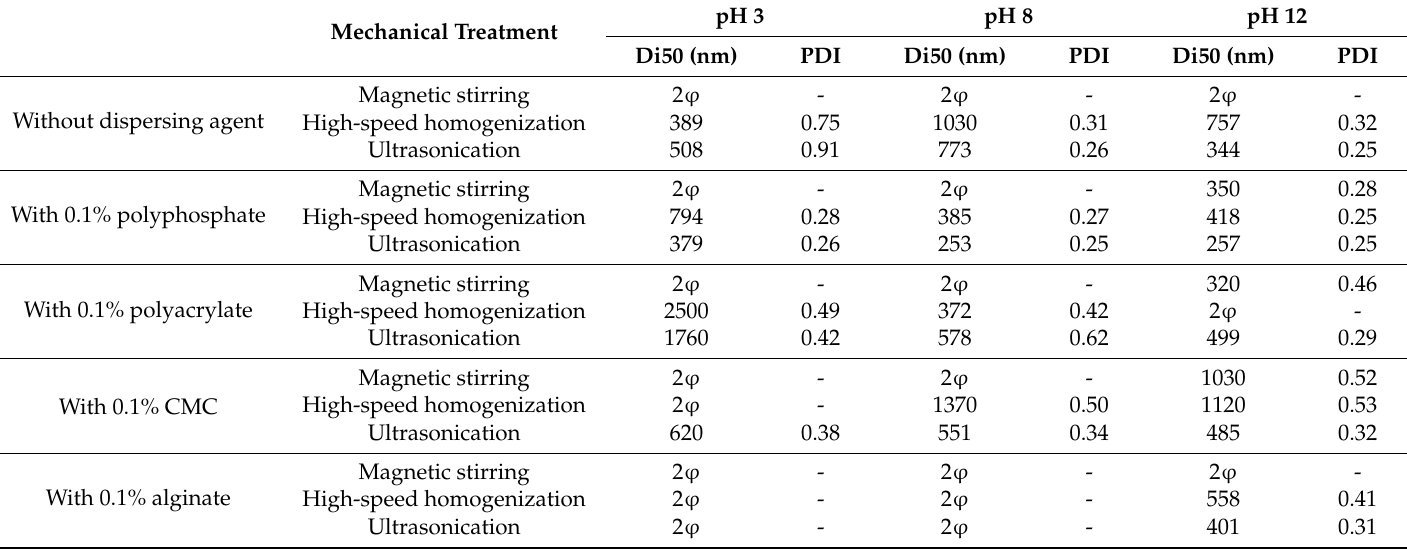
Table 4. Particle sizes of sepiolite 2 as a function of the di ff erent conditions used for preparation of the